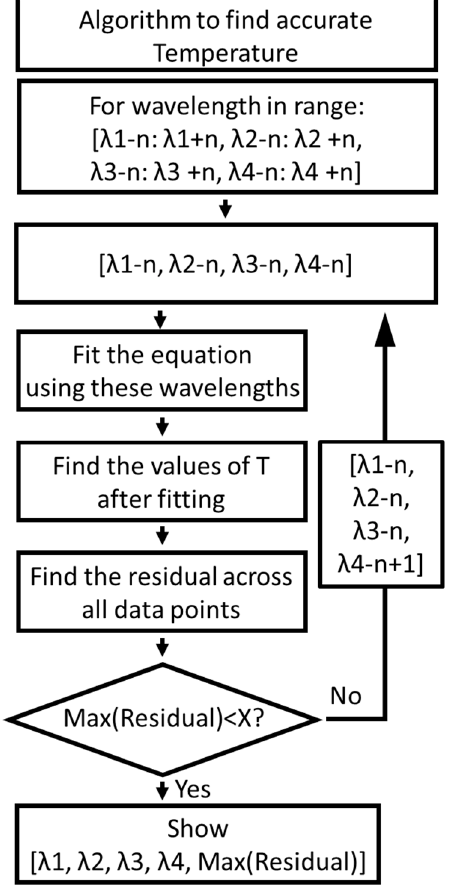
Figure 7. Flowchart outlining the procedure for obtaining four wavelengths for temperature. Note that the fitting for temperature was performed using Equation (4) and R pH and R T represent I( λ 1)/I( λ 2) and I( λ 3)/I( λ 4), respectively; X represents 1.2 °C for temperature.